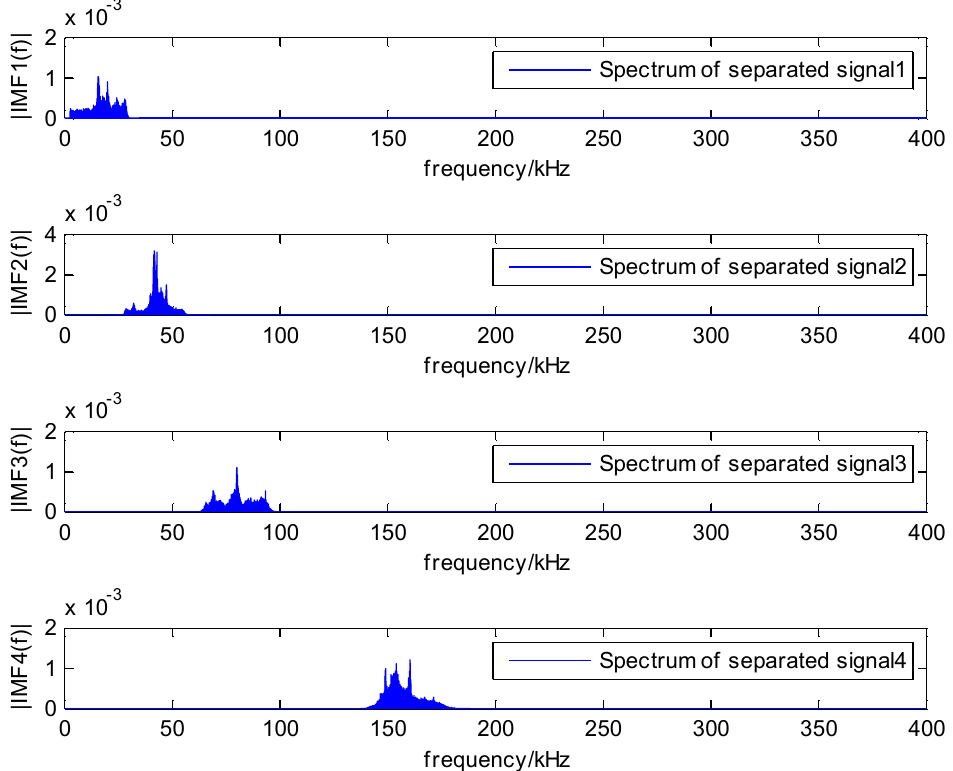
Figure 18. The spectrum of separated signals of sensor 1.